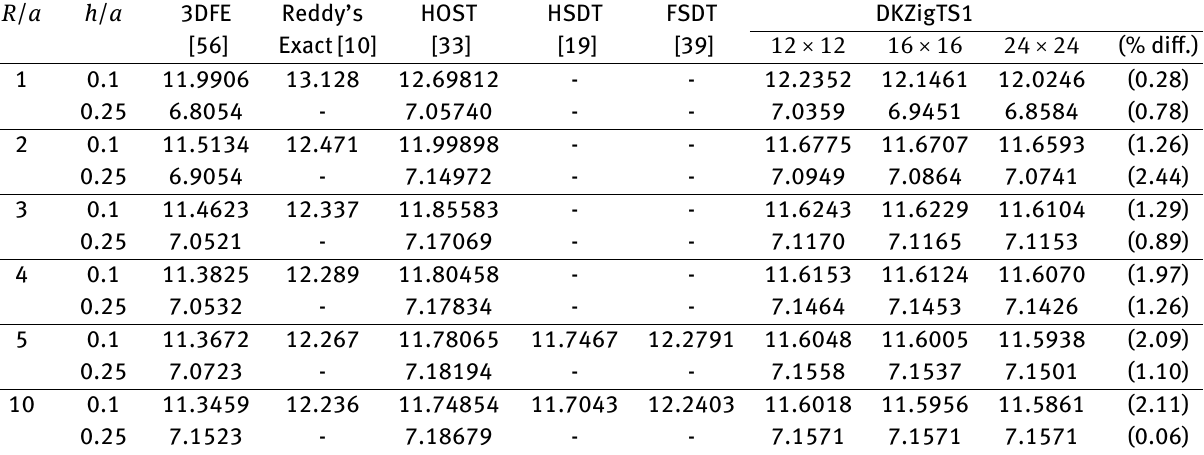
Table 3: Non-dimensionalised natural frequencies ¯ ω for an all-round simply supported composite cylindrical shell panel ‘C’ with b / a =